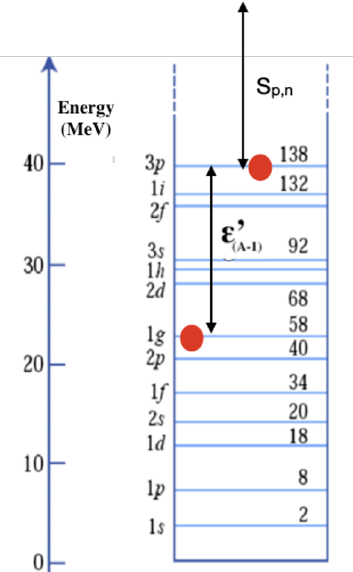
Figure 2 . Pictorial representation of the excitation energy scheme. When a nucleon is removed from a deep shell, the hole energy remains until the nucleus is de-excited. The FG removal energy refers only to Fermi level nucleons, which would correspond to leave the daughter ( A − 1) nucleus in the ground state within this statistical nuclear model. It is an approximation to the experimental proton and neutron separation energies ( S ) of the target nucleus. Knocking out a nucleon p,n from deeper levels will give rise to excited final-nucleus states, equivalent to the binding energy of the nucleon occupying this level ( (cid:15) ). We also show the accumulative occupation numbers when additional shells are considered. The energy scale depicted at the left of the plot has an arbitrary origin, and it is only intended to illustrate the energy differences between